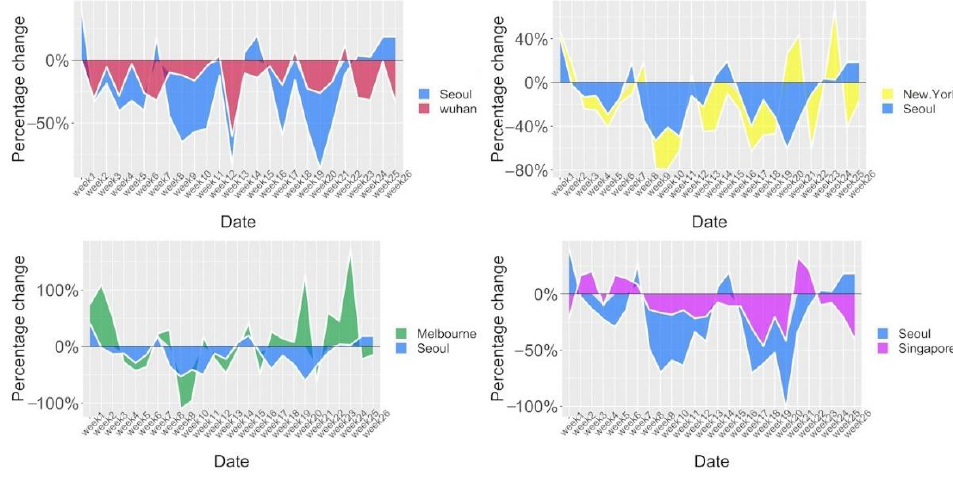
Figure 13. Weekly PM2.5 changing rate comparing Seoul and other cities in 2020. During 2020, except for Seoul, all four other representative cities implemented city closures. The combination of graphs and statistics shows that PM2.5 levels remained in the range of ± 15.7% of 127 from week 39 to 46 in Wuhan, and ± 11.6% of 43 from week 32 to 41 in Singapore. This suggests that PM2.5 levels in Wuhan and Singapore were essentially stable during the second half of 2020. In contrast, PM2.5 levels in New York and Melbourne fluctuated during the same period. Air quality may be affected by the implementation of lockdown policies by local governments, though this effect has not yet been studied.